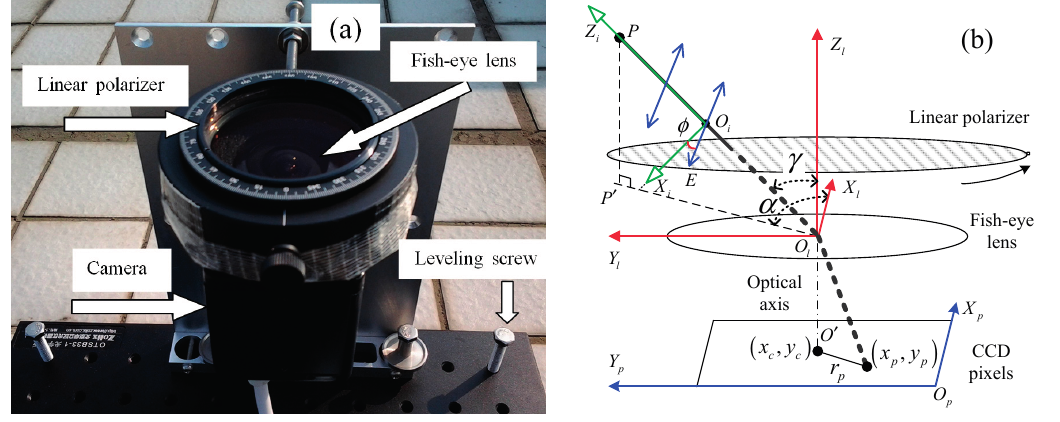
Figure 1. ( a ) The polarization measurement system; ( b ) Schematic representation of the